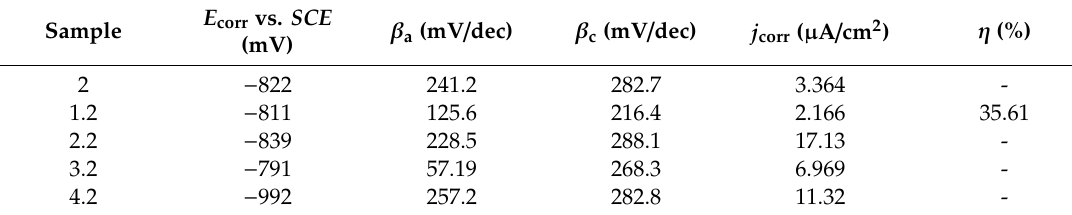
Polarization test results in distilled water, at a temperature (23 ± 2) ◦ C, with and without inhibitor.